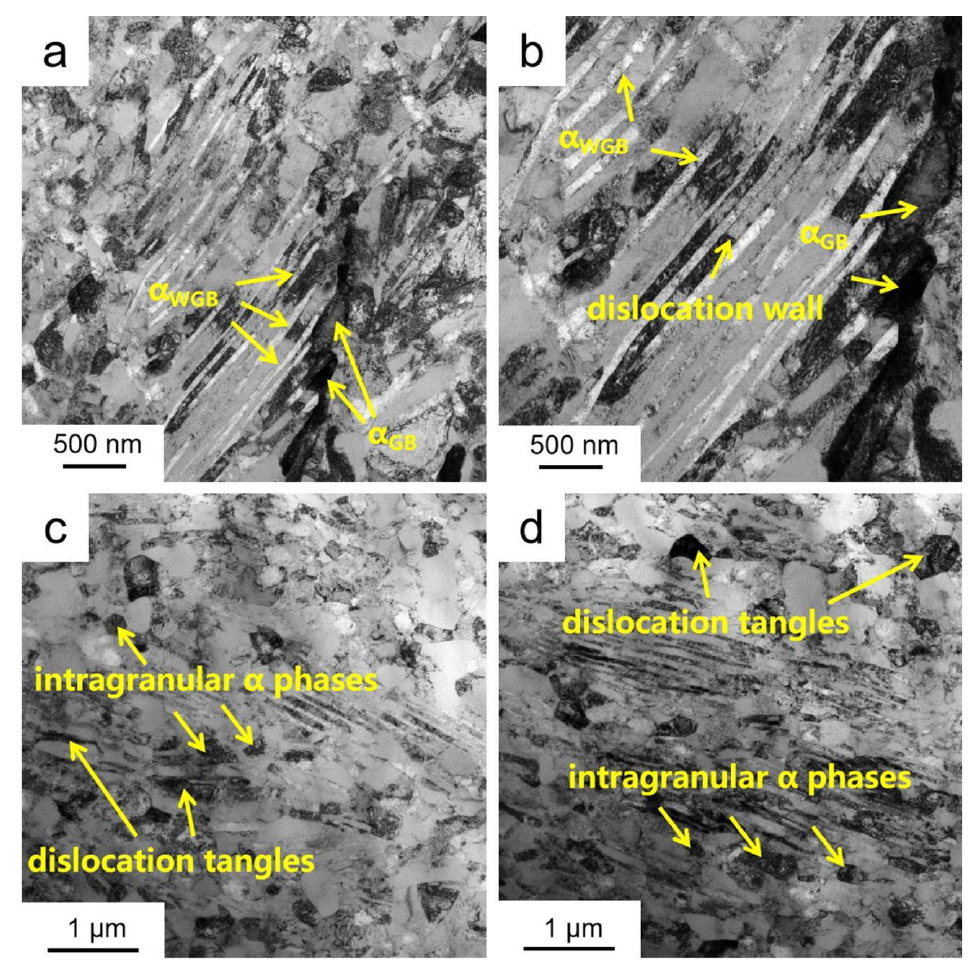
Figure 7. Bright-field (BF) TEM images of α precipitates formed in an air-cooled Ti-B12 alloy after hot compression at a true strain of 0.8: ( a , b ) grain boundary α phases; ( c , d ) α precipitates inside of β grains.